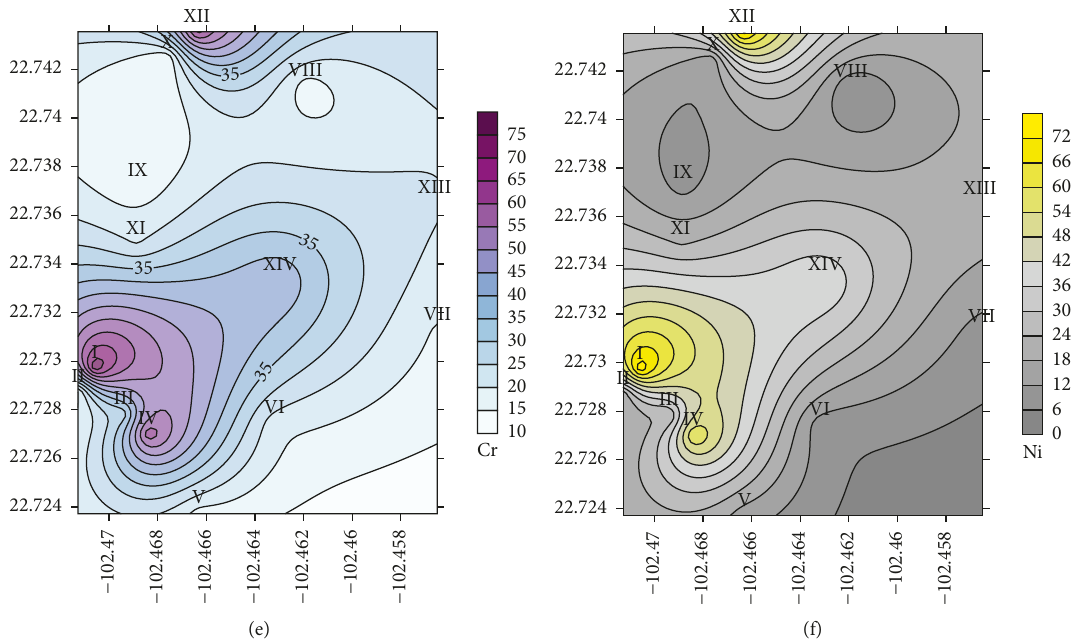
Figure 2: Spatial distribution of heavy metal concentrations in the area of the La Zacatecana Lagoon. (a) Lead, (b) arsenic, (c) mercury, (d) cadmium, (e) chromium, and (f) nickel. Values are expressed as mg